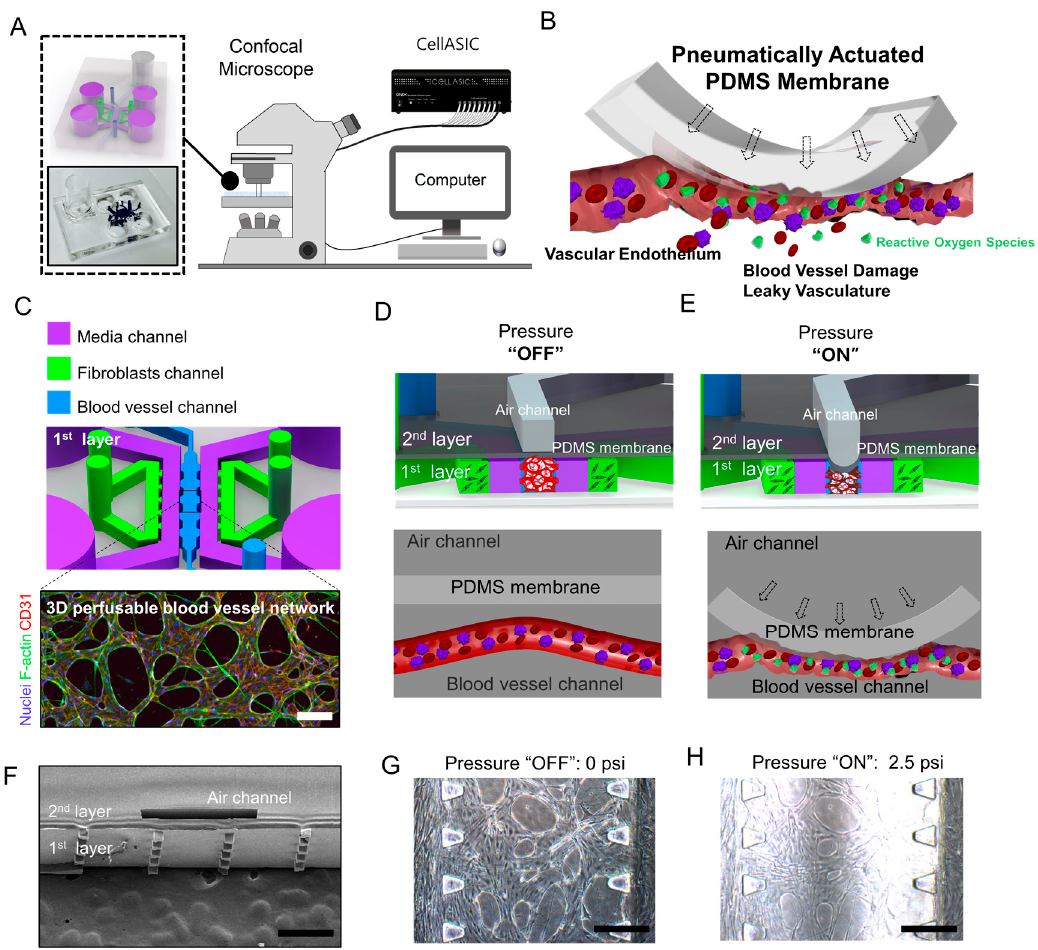
Figure 1. Multilayer microfluidic device for mimicking solid-stress-induced blood vessel compression and collapse in vitro. ( A ) Schematic diagram of the experimental setup. ( B ) Schematic illustration of the pneumatically actuated microfluidic platform for studying blood vessel compression. ( C ) Magnified rendered image in the cell culture layer and 3D vascularized microvessels characterized by immunofluorescence and vasculogenesis on day 5. Scale bar: 100 μ m. ( D ) Configuration of the microfluidic device with the air channel in the “OFF” state, representing that there was no applied pressure. ( E ) Configuration of the microfluidic device with the air channel in the “ON” state, where air pressure was applied to the channel. Polydimethylsiloxane (PDMS) membrane deflection could induce in vitro blood vessel compression in a controlled manner. ( F ) Cross-sectional SEM image of the device. ( G , H ) Bright-field microscopy images of in vitro blood vessels in the device at 0 psi and 2.5 psi, respectively.